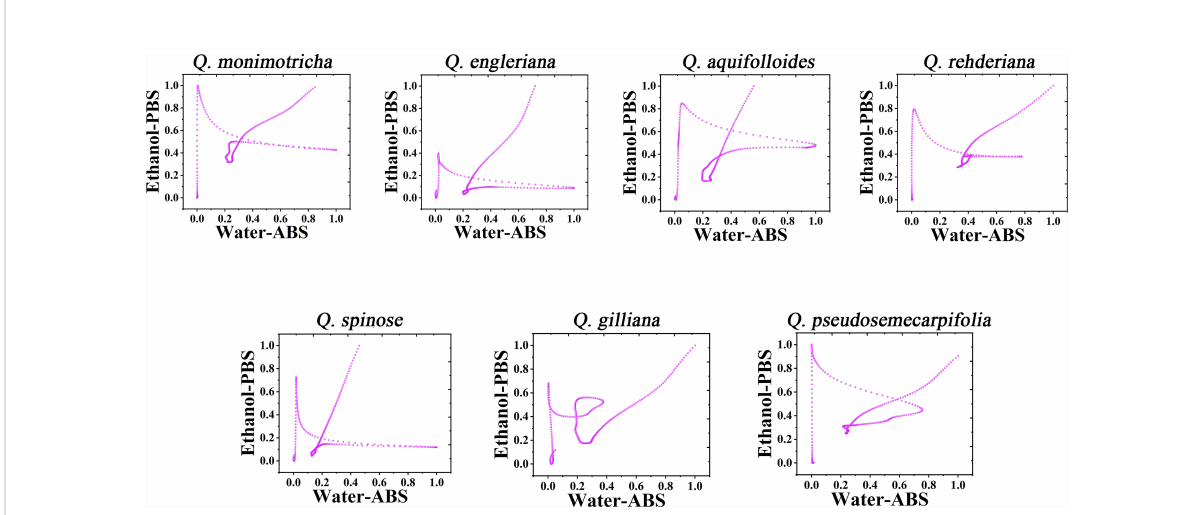
FIGURE 3 Scatter plots of Q. monimotricha, Q. engleriana, Q. aquifolioides, Q. rehderiana, Q. spinosa, Q. gilliana and Q. pseudosemecarpifolia combining the signals collected under ABS for the water extracts and under PBS for the ethanol extracts.